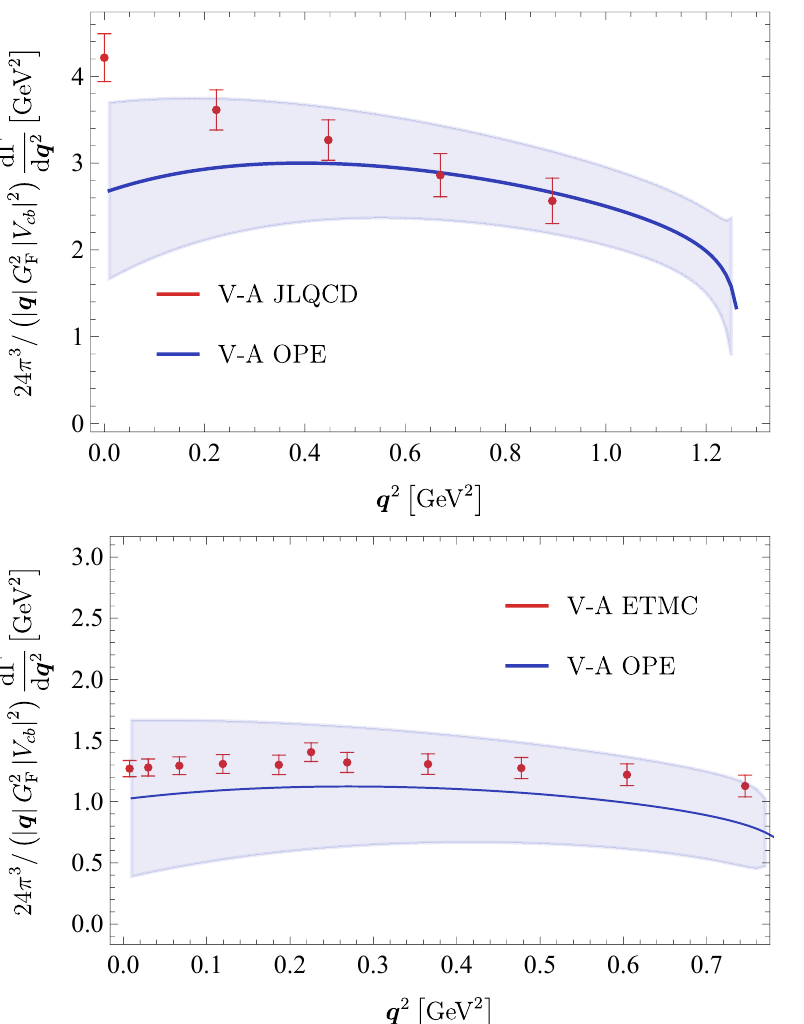
Figure 14 . Differential q 2 spectrum, divided by | q | , in the SM. Comparison of OPE with JLQCD (top panel) and ETMC (bottom panel) data are